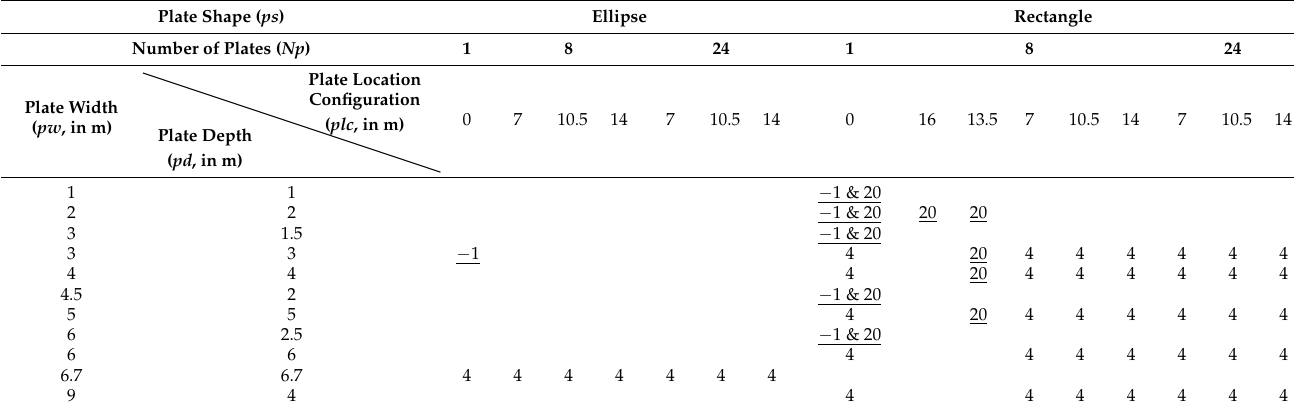
Table 2. Distribution of the wamit water depth, h , for the Wavepiston WEC configuration parameters. When a configuration assesses all h , the cell number is “4”; otherwise, the underlined numbers show the exact h value(s). Plate Shape ( ps ) Ellipse Rectangle Number of Plates ( Np ) Plate Width ( pw , in m) Plate Depth ( pd , in m) Plate Location Plate Configuration Width m)